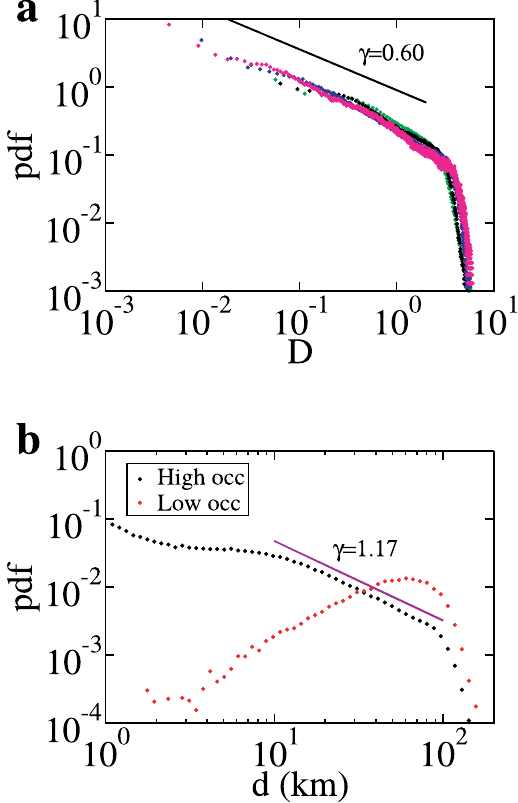
Figure 2. Analysis of displacements. ( a ) Probability density function (pdf) of normalized displacements D for 0.5 day (green), 1 day (black), 4 days (blue), and 10 days (magenta). The pdf’s collapse into a universal function: for displacements below the average ( D < 1), the probability decays as a power-law with exponent γ = 0.60, while for larger displacements, the pdf decays abruptly; ( b ) Distribution of displacements d for origins located at both high (black) and low (red) occupancy grid cells with T = 1